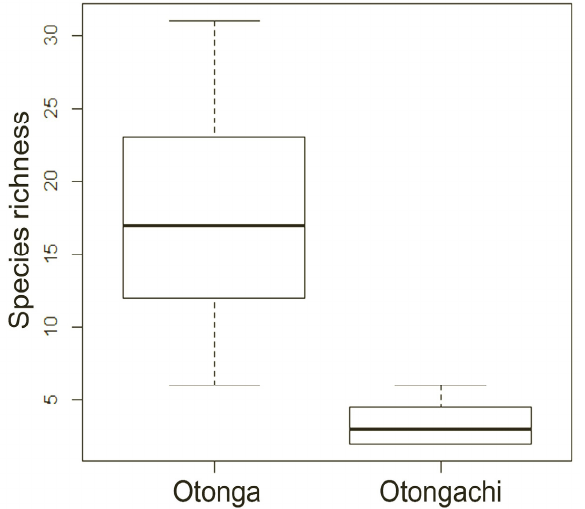
Figure 5. Differences in species richness per plot between Otonga and Otongachi. The difference between the species richness per transect between the primary and secondary forests, considering both reserves, was also significant (MW, V = 63, p = 0.04), with a p -value higher than that obtained from the reserve comparison. However, these results were essentially determined by the differences in species richness between Otonga and Otongachi. No significant difference emerged, in fact, in species richness between primary and secondary forest in Otonga (mean number of species per plot 18.0 ± 3.7, with 36.5 ± 10.0 specimens in the primary forest, 17.4 ± 7.5 species with 34.8 ± 7.5 specimens per plot in the secondary forest, MW: V = 15.5, p = 1.0). There was no significant difference in the mean species richness per plot observed in any of the following cases: between plots with high or low moss_index (MW: V = 31, p -value = 0.3); between plots with high or low rotten_log index (MW: V = 26, p -value = 0.13); between plots with different litter moisture (dryness_index, KW: χ 2 = 5.34, df = 2, p -value = 0.07); between plots with different canopy coverage (KW: χ 2 = 3.15, df = 3, p -value = 0.37). A significant correlation was found be- tween elevation and species richness (Spearman’s correlation, ρ = 0.895, p < 0.001). Species richness increased as a function of elevation, apparently more markedly above 1700 m, although information on species richness at intermediate elevations between Otongachi and Otonga would be needed to confirm this finding (Figure 6).